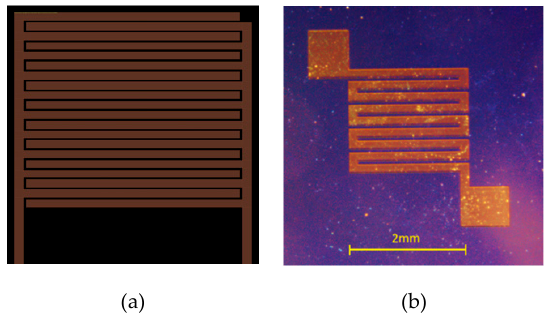
Figure 1. Representation of the microfabricated patterns on ( a ) top, interdigitated fingers; and ( b ) bottom, microheater.